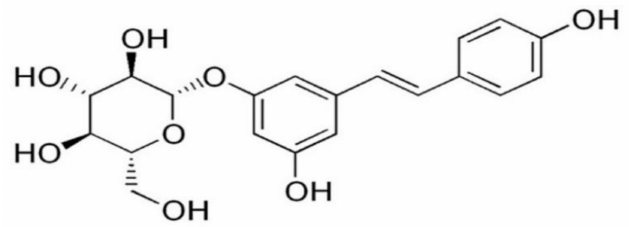
Figure 1. Chemical structure of